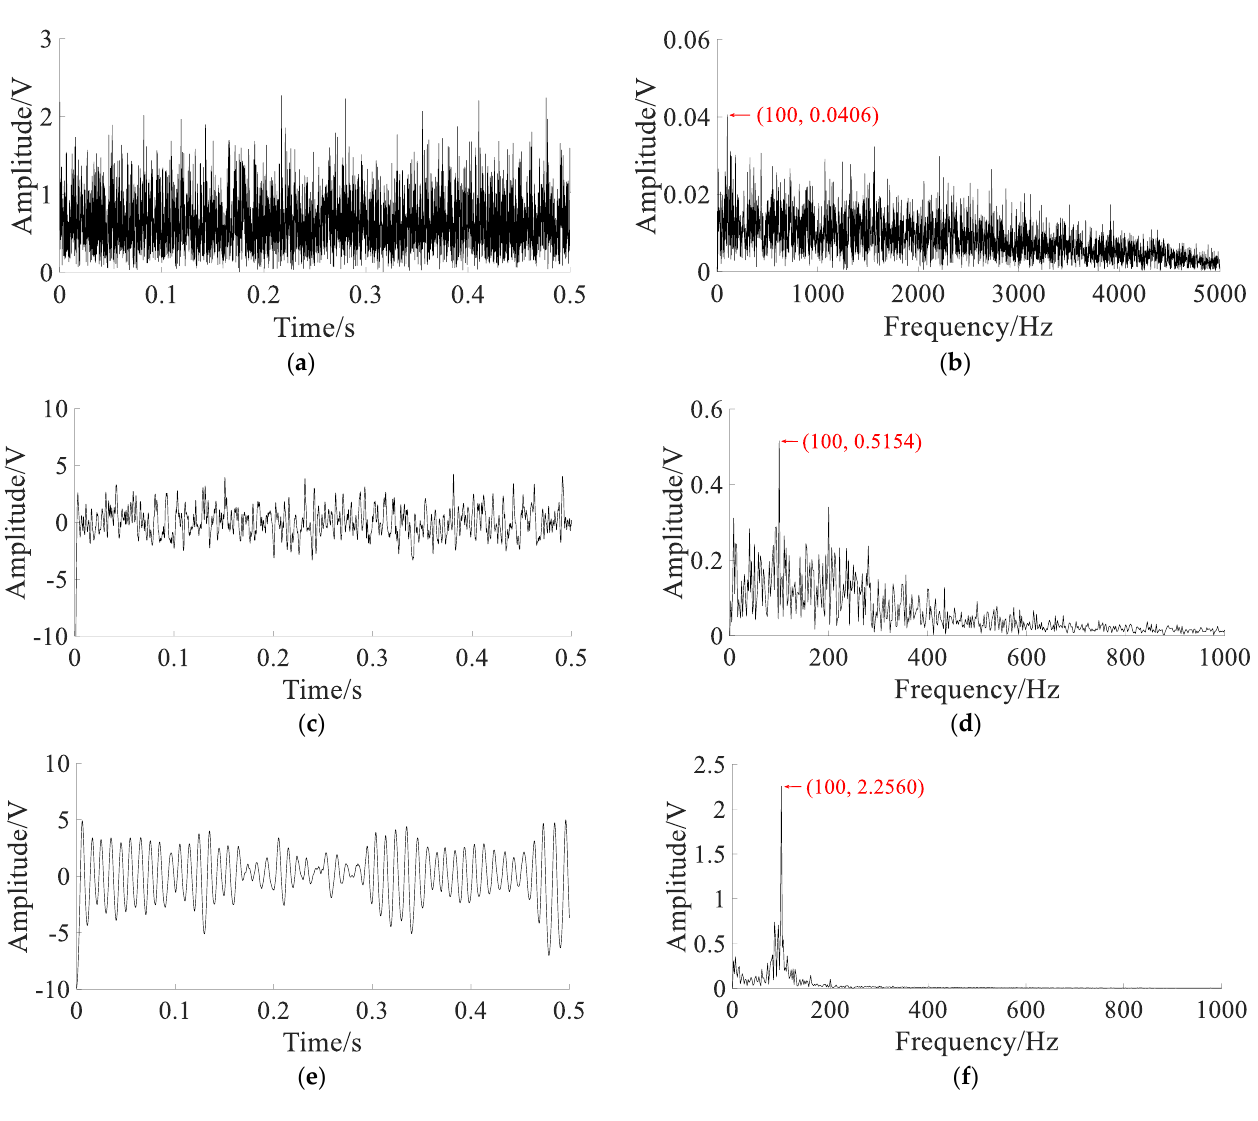
( d ) Figure 11. The simulated signals: ( a ) pure signal; ( b ) spectrum of pure signal; ( c ) noisy signal; ( d ) spectrum of noisy signal. Figure 11a,b show that the characteristic frequency